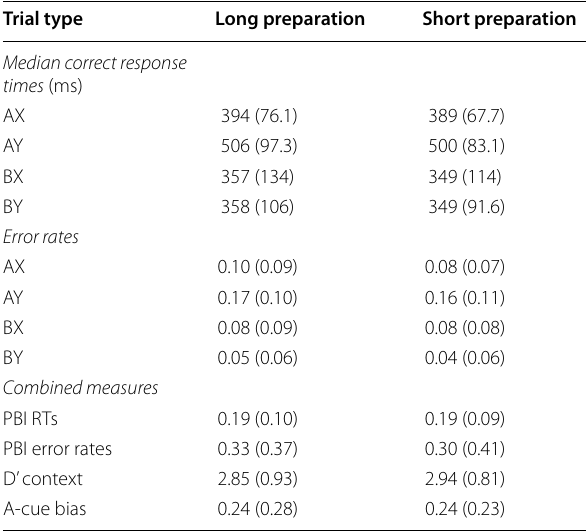
Shown are average values with standard deviations in